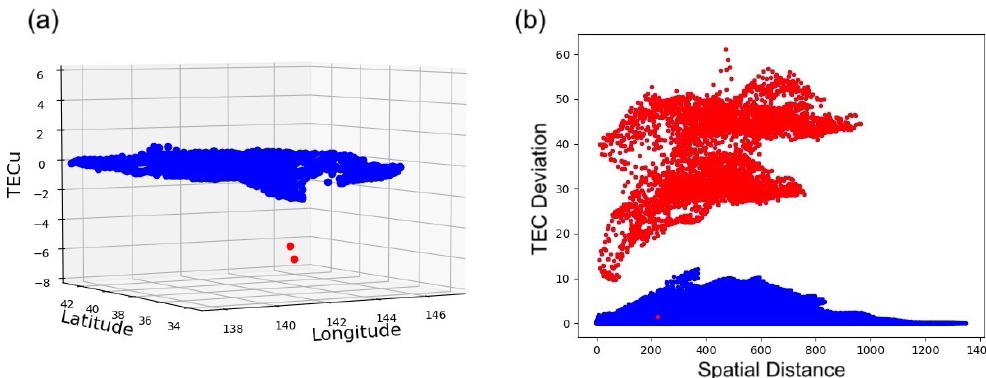
Figure 4. Panel (a) is the 3D plot of the captured data. The two red dots are outliers identified by our method. Panel (b) is the semi-variogram cloud of the data. In both panels (a) and (b) , the data depicted and analyzed are captured by satellites at 06:00:00